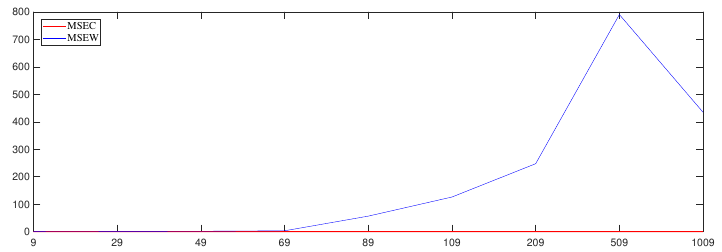
Figure 5. Folding line plot of the compared mean square error for a variance of 1.